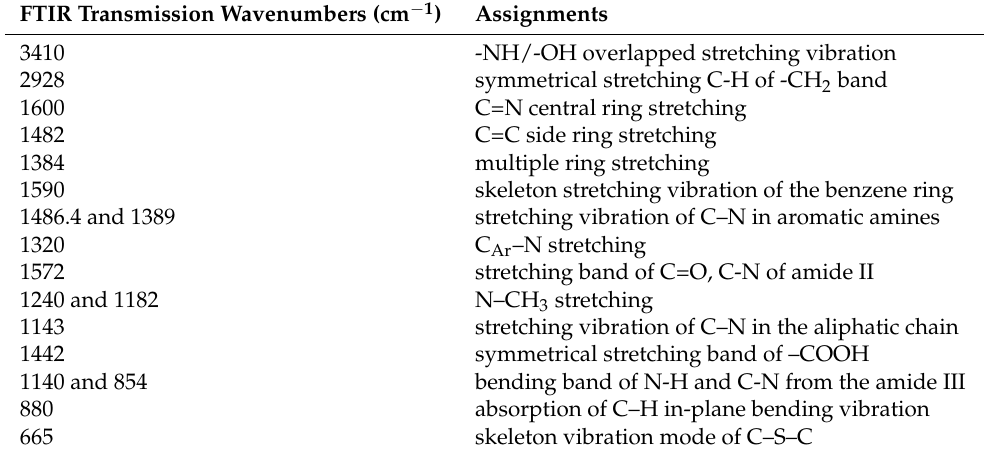
Table 1. FTIR spectra and assignment of MB